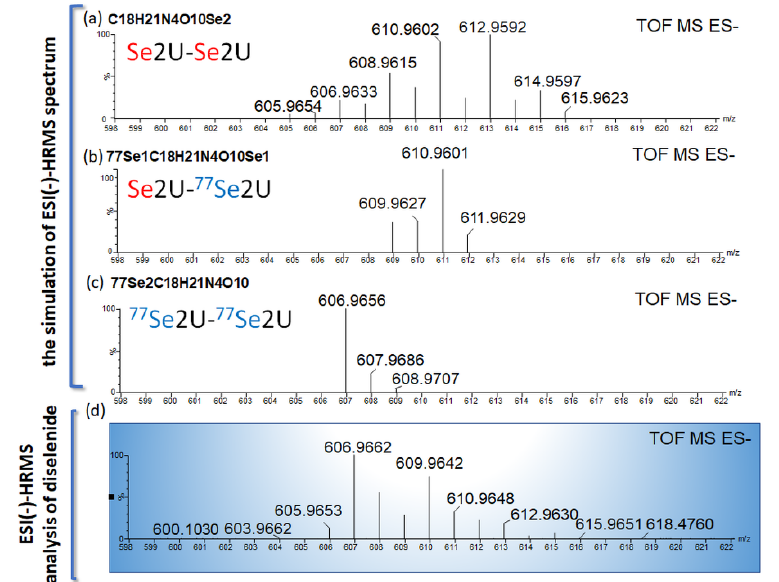
Figure 6. The LC–MS exchange experiment was performed with diselenide (Se2U) 2 (containing a selenium isotope mixture of natural abundance) and 77 Se2U (containing 100% 77 Se). The reaction was carried out in water at rt. for 5 min, and then the spectrum (( d ), in blue rectangle) was recorded. It shows the signals for diselenide 77 Se- 77 Se, diselenide 77 Se-Se, and Se-Se with characteristic selenium isotope distribution. Spectra ( a – c ) represent simulated spectra for respective, differently labeled diselenides.